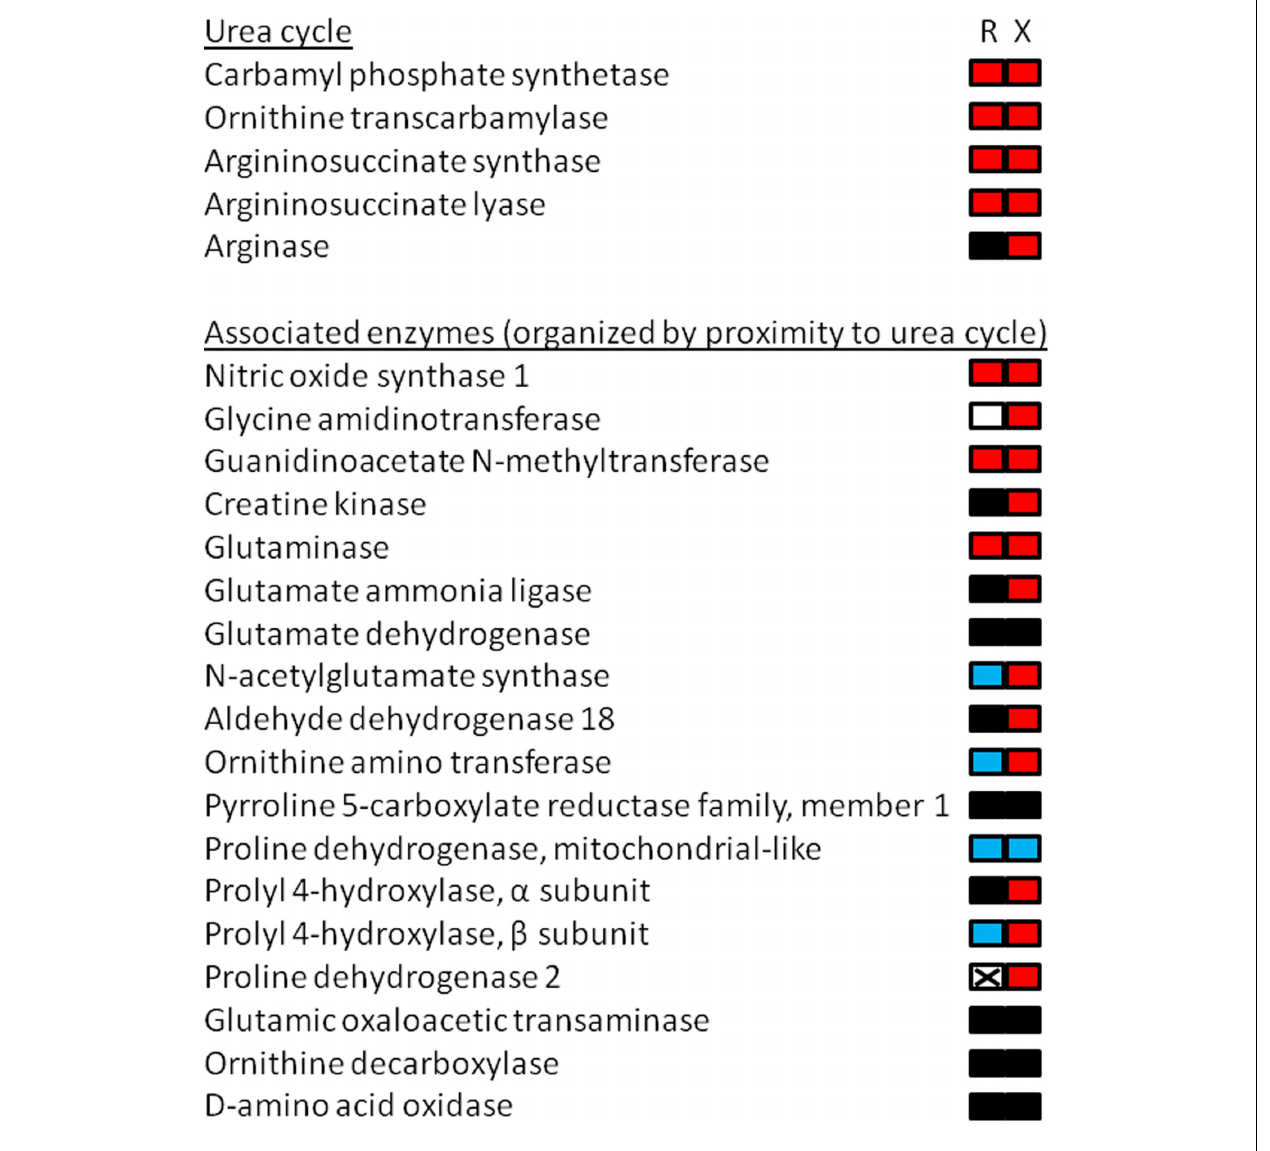
beside the name of the enzymes corresponding with measured transcripts in the RNA-seq experiment that were identified in the KEGG pathway.The left side represents the relative change in transcript abundance levels of Rana (R) and the right side mRNA levels of Xenopus (X) where red is increased, black is no change, and blue is decreased relative to control animals. Non-detected transcript is depicted by a crossed-out white box. Use of the X. tropicalis genome as an assembly scaffold had limited utility since X. laevis and R. catesbeiana sequences aligned imperfectly to the X. tropicalis genome with R. catesbeiana , not surprisingly, having the least benefit of alignment. Nevertheless, some transcript identities linked to count frequencies were positively confirmed and the data obtained for the urea cycle enzymes, for example, matched well with previous observations (Helbing et al., 1992; Xu et al., 1993; Iwase et al., 1995).This validates the method for transcripts that are identifiable and quantifiable in this